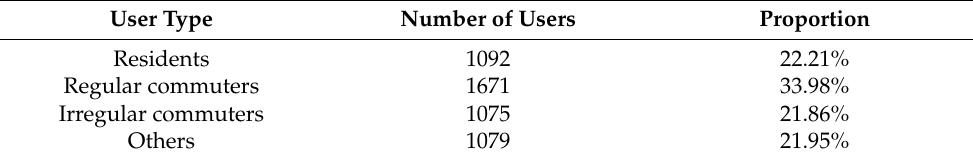
Table 5. User classification